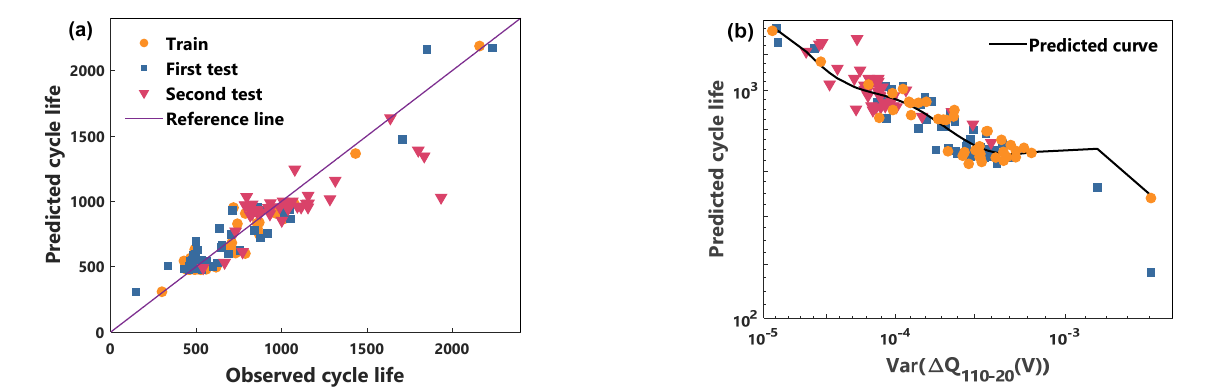
Figure 7. NGP and voltage characteristic model cycle life prediction. ( a ) Comparison of observed life and predicted life, ( b ) the cycle life predicted curve.